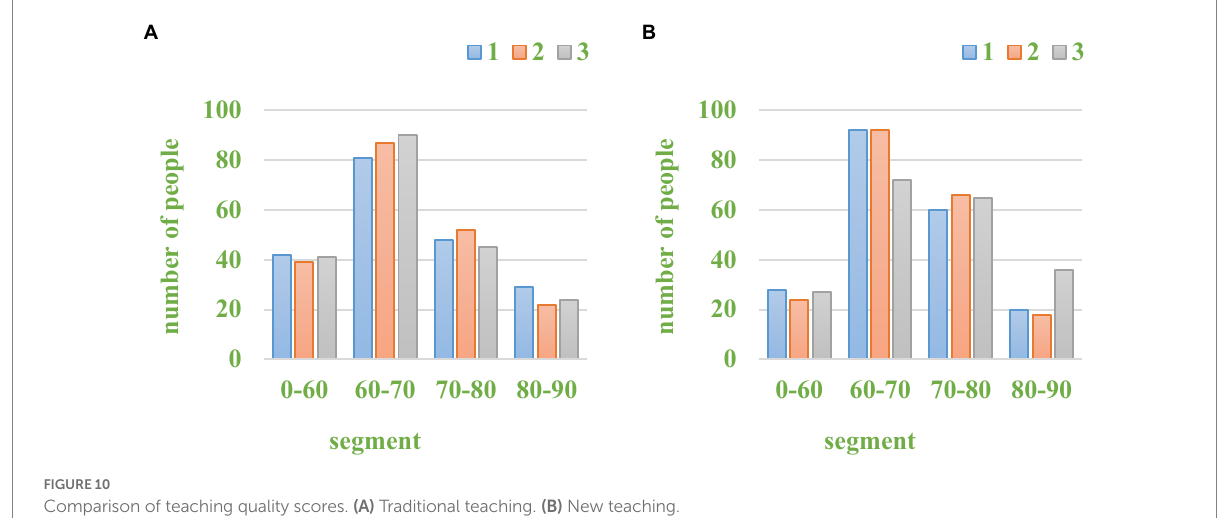
FIGURE 10 Comparison of teaching quality scores. (A) Traditional teaching. (B) New